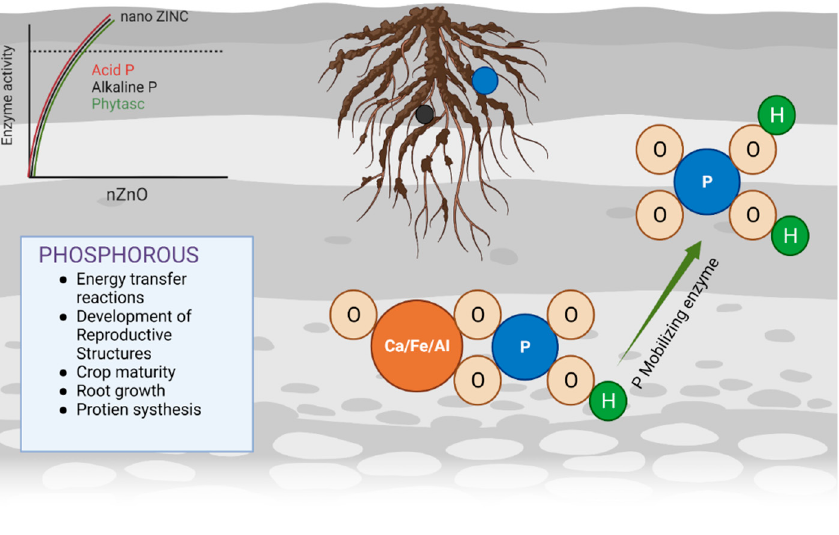
Figure 1. ZnO nanoparticle (NP) treatment increases the activity of P-mobilising enzymes. Conse- quently, plants uptake Zn ions, and native P mobilisation occurs in the rhizosphere.